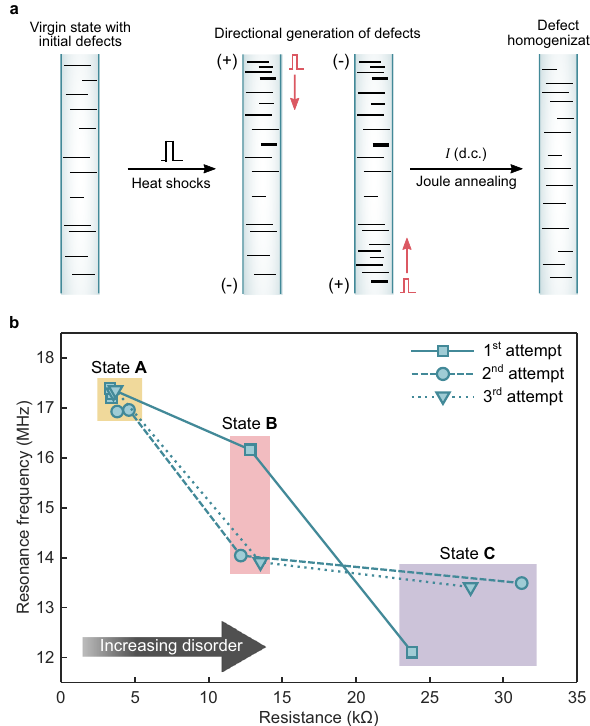
Fig. 3 Partial lattice relaxation process in phase-change nanowires via defect engineering and its utilization as a frequency tuning